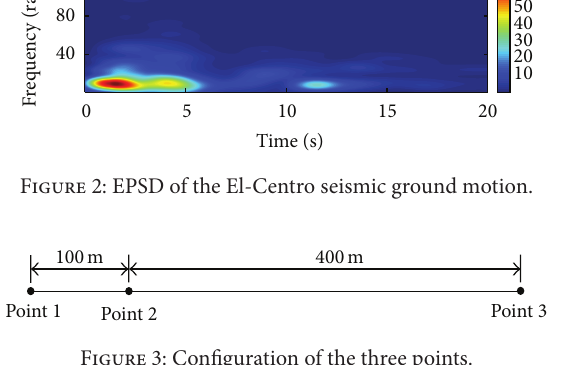
Figure 4: A set of sample time histories of seismic ground